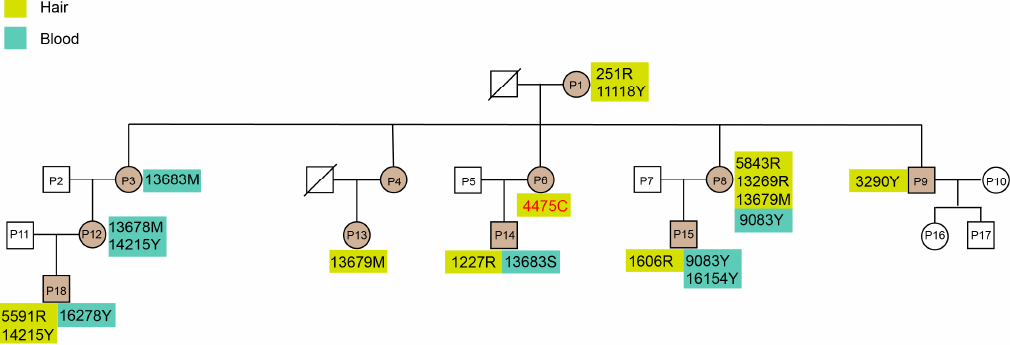
Figure 8. Point heteroplasmy variants in the four-generation pedigree. Variants with a yellow background were observed in hair shafts, and variants with a blue background were observed in blood samples. Individuals with a white background were not included in this study.